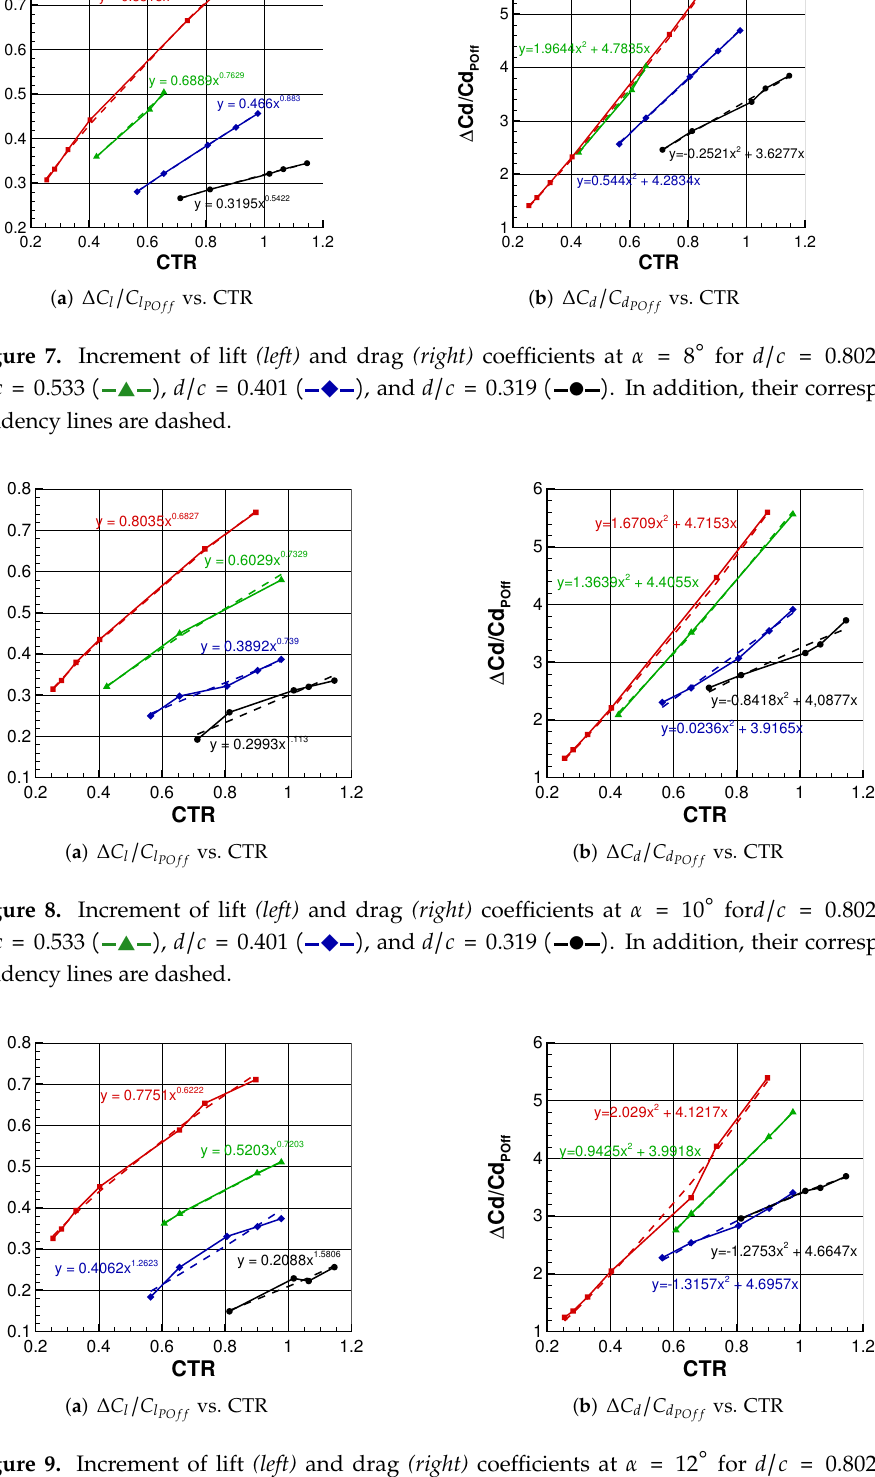
Figure 9. Increment of lift (left) and drag (right) coefficients at α = 12 d / c = 0.533 ( ▲ ) , d / c = 0.401 ( ◆ ) , and d / c = 0.319 ( ● ) . In addition, their corresponding tendency lines are